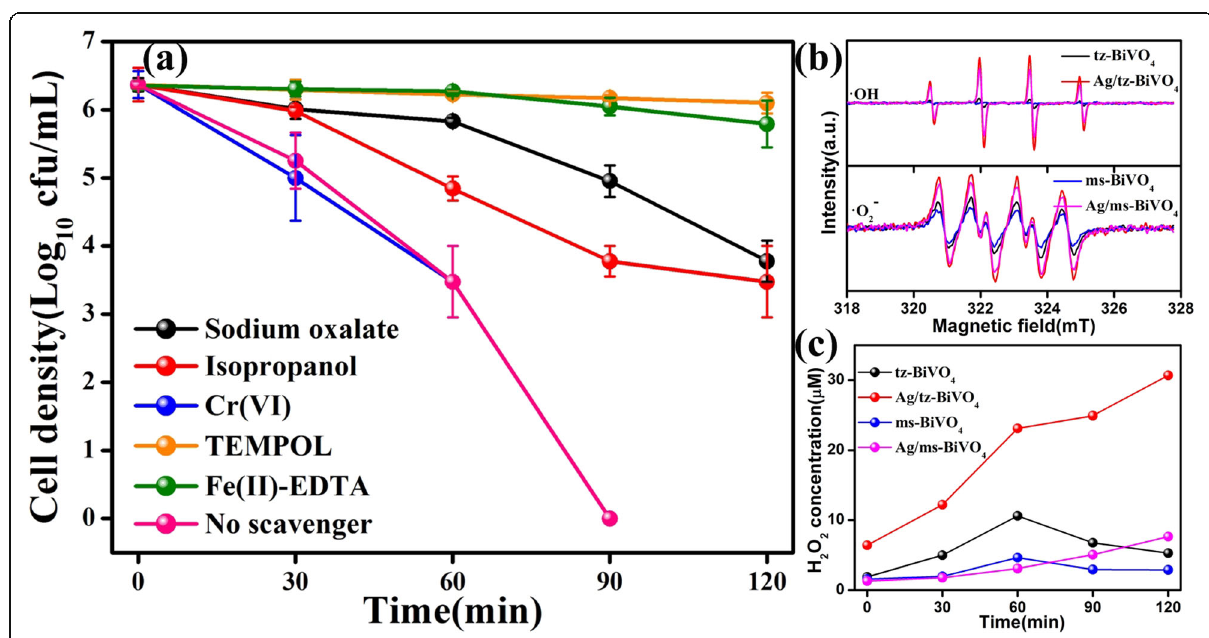
Fig. 6 Photocatalytic inactivation efficiencies with respective scavengers in the presence of Ag/tz-BiVO 4 ( a ). EPR spectra of (cid:129) OH and DMPO- (cid:129) O 2 − in the presence of pristine tz-BiVO 4 , Ag/tz-BiVO 4 , pristine ms-BiVO 4 , and Ag/ms-BiVO 4 under VL irradiation ( b ). Relative concentration of H 2 O 2 by pristine tz-BiVO 4 , Ag/tz-BiVO 4 , pristine ms-BiVO 4 , and Ag/ms-BiVO 4 (the pH of the suspension was adjusted to 9 using NaOH and took 3.5 mL; 50 μ L of 0.7 mM lucigenin solution was added) ( c